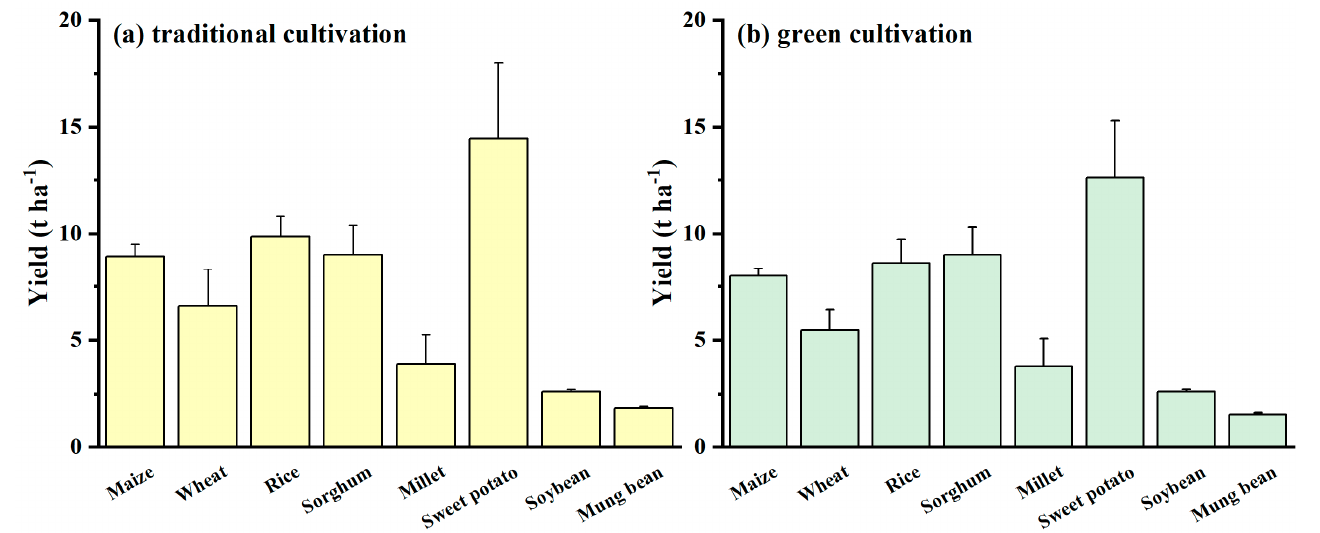
Figure 4. Crop yields in ( a ) traditional cultivation and ( b ) green cultivation systems in the Huang- Huai-Hai farming region in 2018. The bar and whisker are the average value and standard deviation of yield for each crop across all the investigated sites, respectively. Sweet potato dry matter was converted from fresh weight using a coefficient of equivalent yield (0.23)[63].